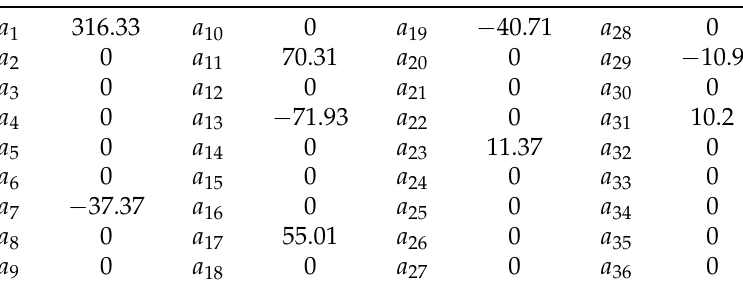
Table 3. The fourier coefficients a n .